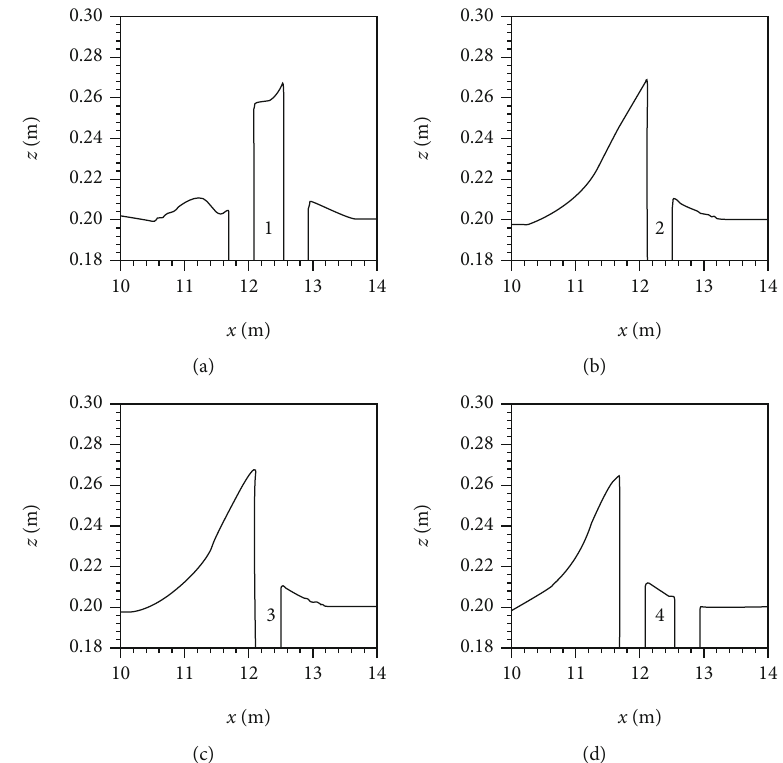
Figure 7: The maximum solitary wave run-ups at each cylinder for the diamond arrangement; (a) cylinder 1; (b) cylinder 2; (c) cylinder 3; (d) cylinder 4.